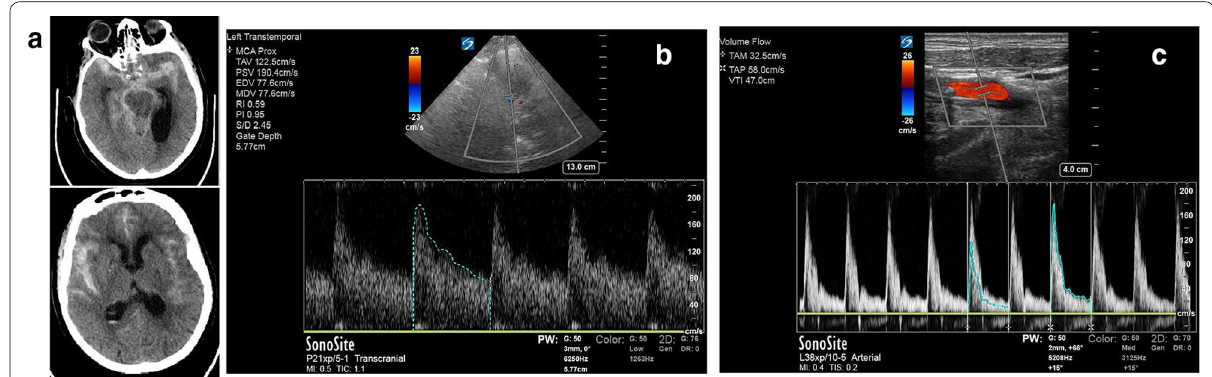
Fig. 2 Transcranial Doppler for vasospasm following subarachnoid hemorrhage. a CT Head demonstrating diffuse subarachnoid hemorrhage. b TCD measurement of left MCA flows, demonstrating a mean MCA velocity of 123 cm/s (in-keeping with mild vasospasm). c Measurement of ipsilat-